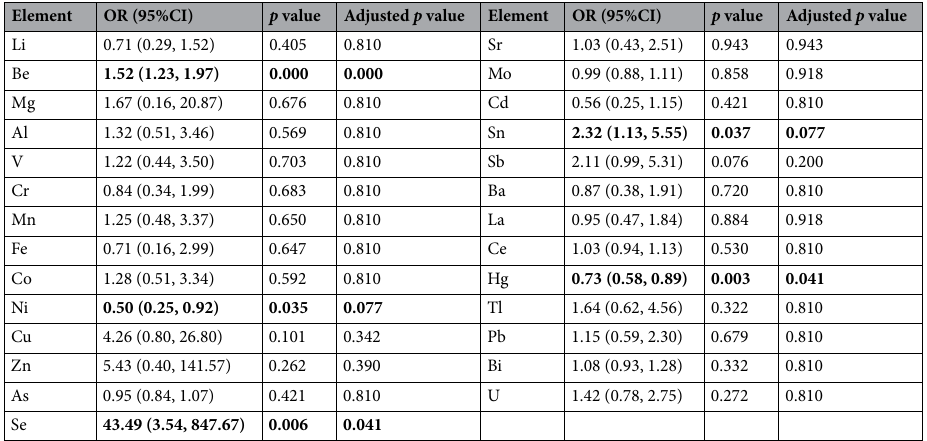
Table 3. Adjusted odd ratio (OR) of elements in fingernails for the risk of GDM. Odd ratio adjusted for education level, income, passive smoking, physical activity pattern, family history of diabetes, parity, age and pre-pregnancy BMI. Bold: p value < 0.05 by logistic regression analysis. FDR correction was indicated in adjusted p value (significant level: p value <